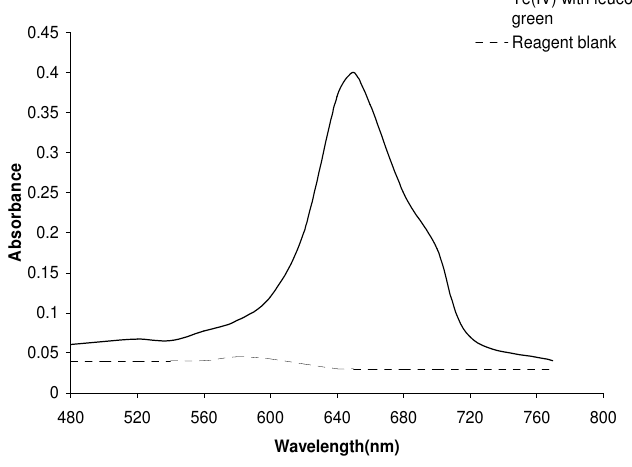
Figure 1.Absorption spectra of Te(IV) with leuco methylene